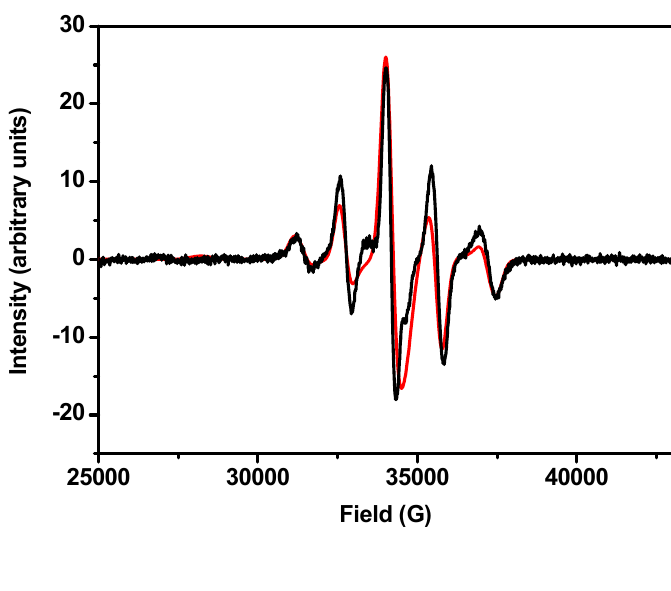
Figure 6. W-band EPR spectrum of a polycrystalline sample of 5 (black) and simulation (red) with S = 5/2, D = − 0.14 cm -1 and g =